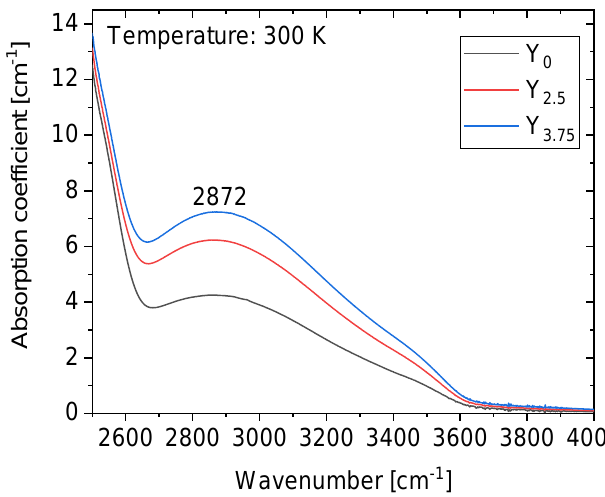
Figure 6. The IR spectrum of the investigated glasses. The refractive index of the glasses was measured at six different wavelengths: 0.532, 0.6542, 0.8464, 1.3082, 1.5491, and 1.6521 µ m with precision ± 0.0005 ( ± 0.001 for 1.6521 µ m) and fitted with the Sellmeier equation with an infrared correction, which was found to best fit the data in this measurement setup [33]: